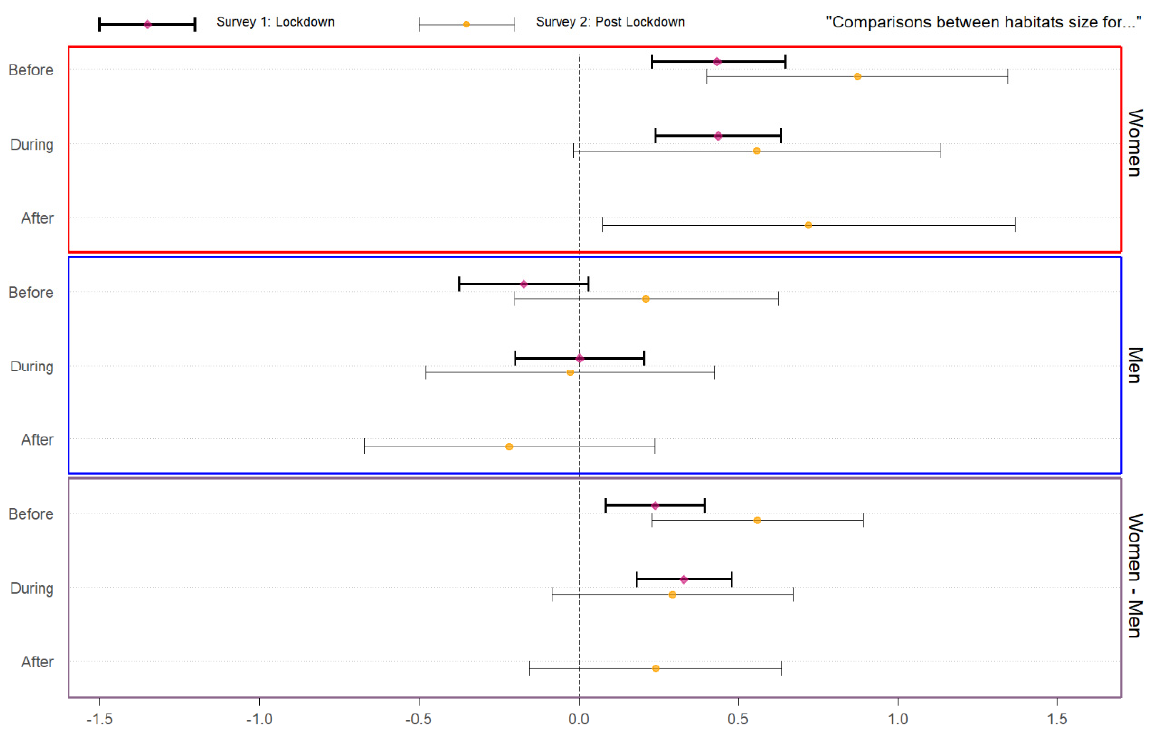
Figure 3. Confidence intervals of mean differences between municipalities by period and for women, men and differences between women and men. This figure shows the confidence intervals for the mean differences between municipality sizes by moment in time with respect to confinement, differentiating for women and men as well as their differences. Differences are not significant at 5% level when the corresponding interval intersects with the zero-vertical dotted line. The interested reader can find detailed numbers, including p-values, in Table A2 of Appendix A.